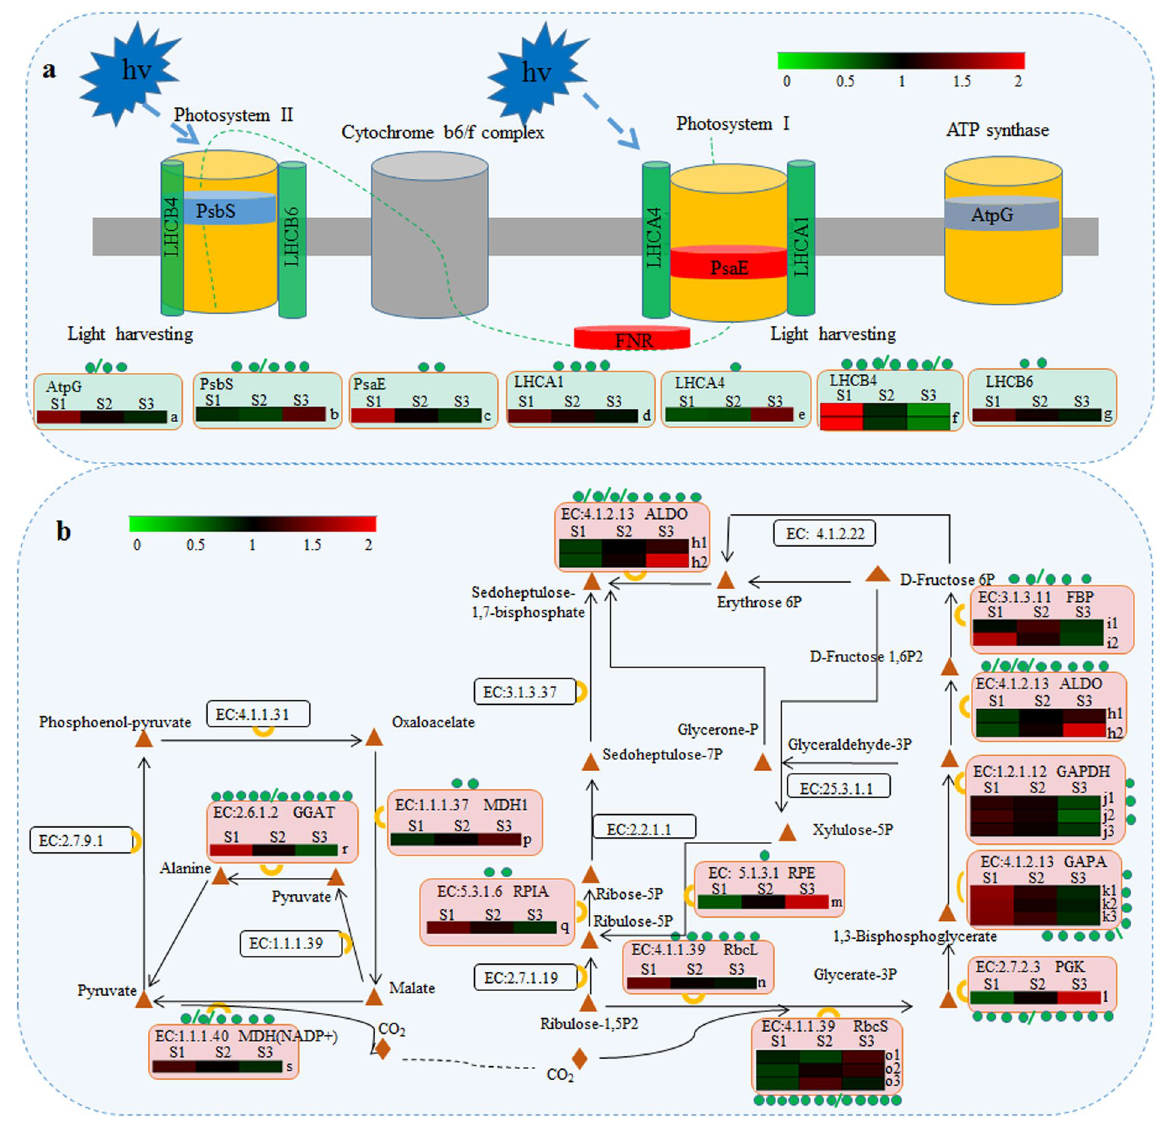
Figure 7. Differentially expressed SSs and SPs involved in photosynthesis and carbon fixation. The number of SSs is indicated by green dots. The succinylation level of differentially expressed SSs during the three ‘Anji Baicha’ developmental stages is shown using a heatmap. PsaE: photosystem I subunit IV; PsbS: photosystem II 22 kDa protein; LHCA1/4: light-harvesting complex I chlorophyll a/b binding protein 1/4; LHCB4/6: light- harvesting complex II chlorophyll a/b binding protein 4/6; AtpG: ATP synthase gamma chain; ALDO: fructose- bisphosphate aldolase, class I; FBP: fructose-1,6-bisphosphatase I; GAPDH/GAPA: glyceraldehyde 3-phosphate dehydrogenase/NADP + ; GGAT: glutamate–glyoxylate aminotransferase; MDH: malate dehydrogenase; PGK: phosphoglycerate kinase; RbcL/S: ribulose-bisphosphate carboxylase large chain/small chain; RPE: ribulose- phosphate 3-epimerase; RPIA: ribose 5-phosphate isomerase A. a: Unigene17303_All, K89; b: CL2225.Contig1_ All, K69; c: Unigene24422_All, K86; d: CL6420.Contig2_All, K98; e: CL8782.Contig1_All, K201; f: CL2645. Contig3_All, K209; g: Unigene3268_All, K56; h1: Unigene22463_All, K387; h2: Unigene48_All, K225; i1: CL1597.Contig1_All, K234; i2: CL509.Contig2_All, K353; j1: CL2420.Contig4_All, K120; j2: CL2420.Contig4_ All, K143; j3: CL2420.Contig4_All, K254; k1: CL4565.Contig2_All, K159; k2: CL4565.Contig2_All, K205; k3: CL4565.Contig2_All, K341; l: Unigene21236_All, K125; m: CL2805.Contig4_All, K275; n: Unigene3523_All, K67; o1: Unigene9029_All, K144; o2: CL3466.Contig1_All, K67; o3: CL3466.Contig1_All, K148; p: CL6967. Contig2_All, K208; q: Unigene22450_All, K214; r: CL1792.Contig2_All,